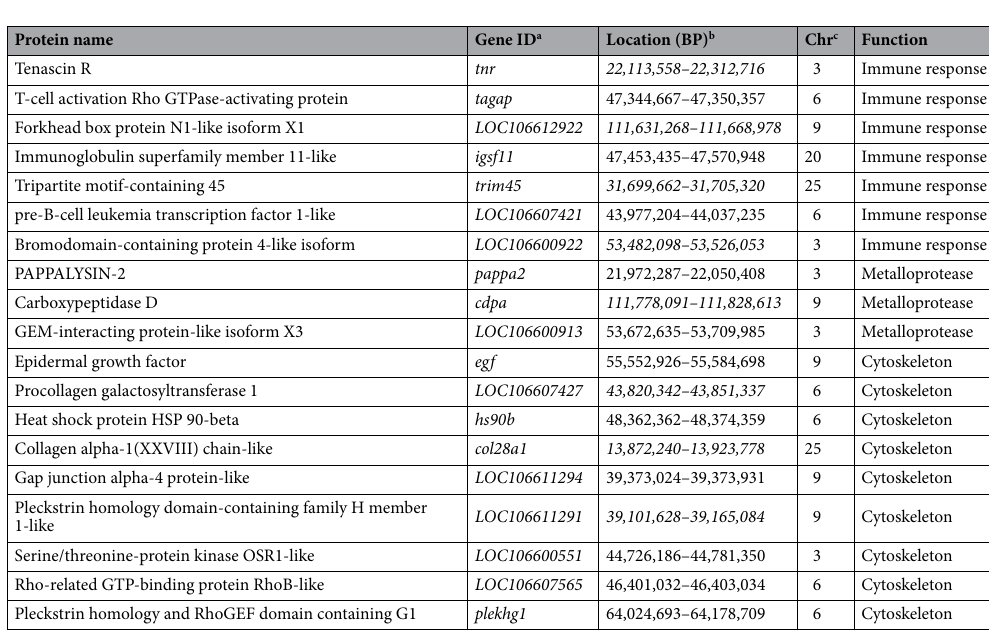
Table 3. Candidate genes for sea lice resistance in Atlantic salmon. a Gene identification (Gene ID) from the NCBI database GenBank assembly accession: GCA_000233375.4. b Location in base pair (bp). c Chromosome